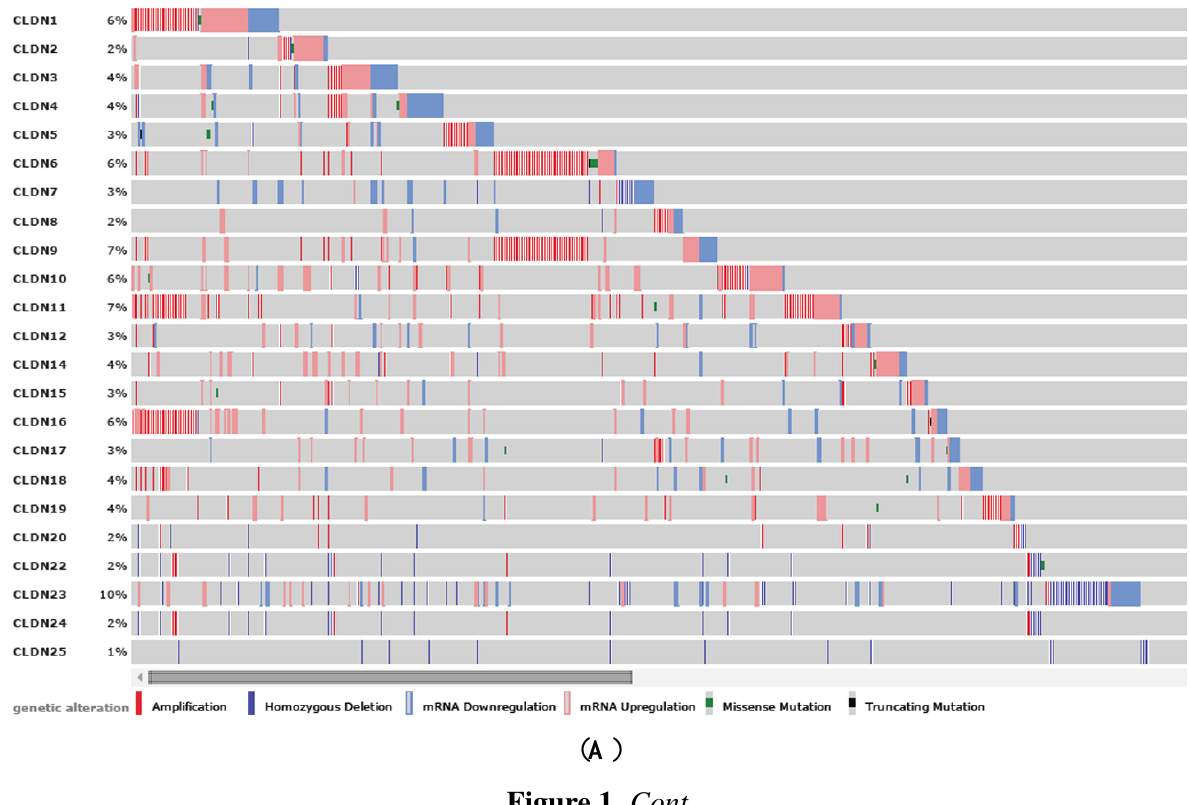
Figure 1. Cont Figure 1. Cont.